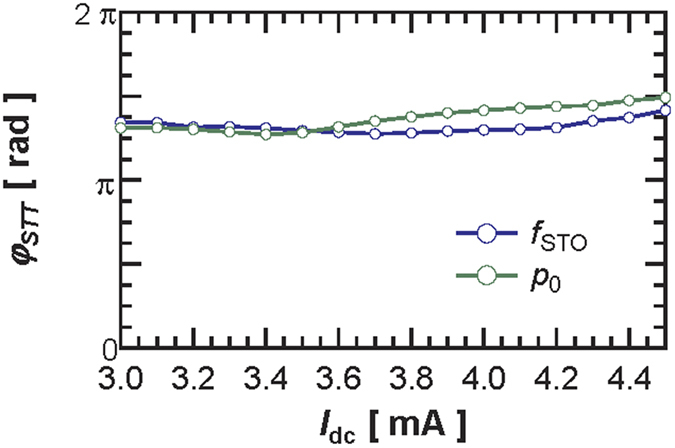
Evolution of the estimated phase shift φSTT with the dc current Idc.